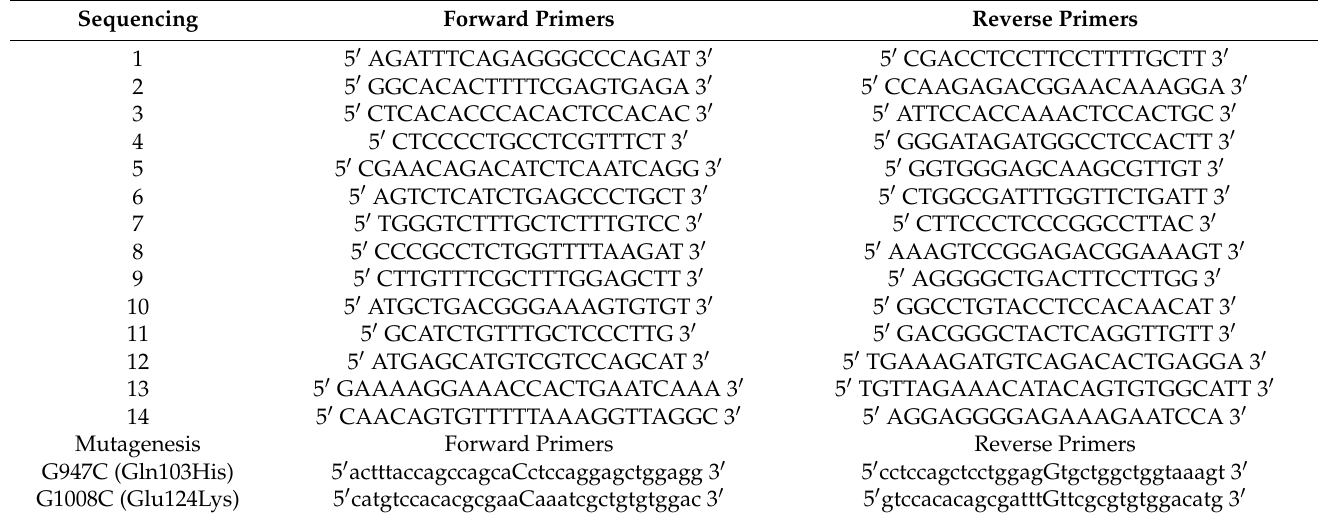
Table 1. Primer sequences used for human PITX2 sequencing and for site-directed